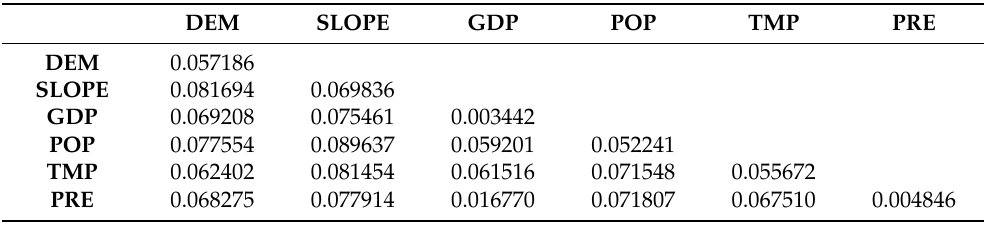
Table A6. The force (q-value) among any two influencing factors on Largest Patch Index (LPI) interactively in